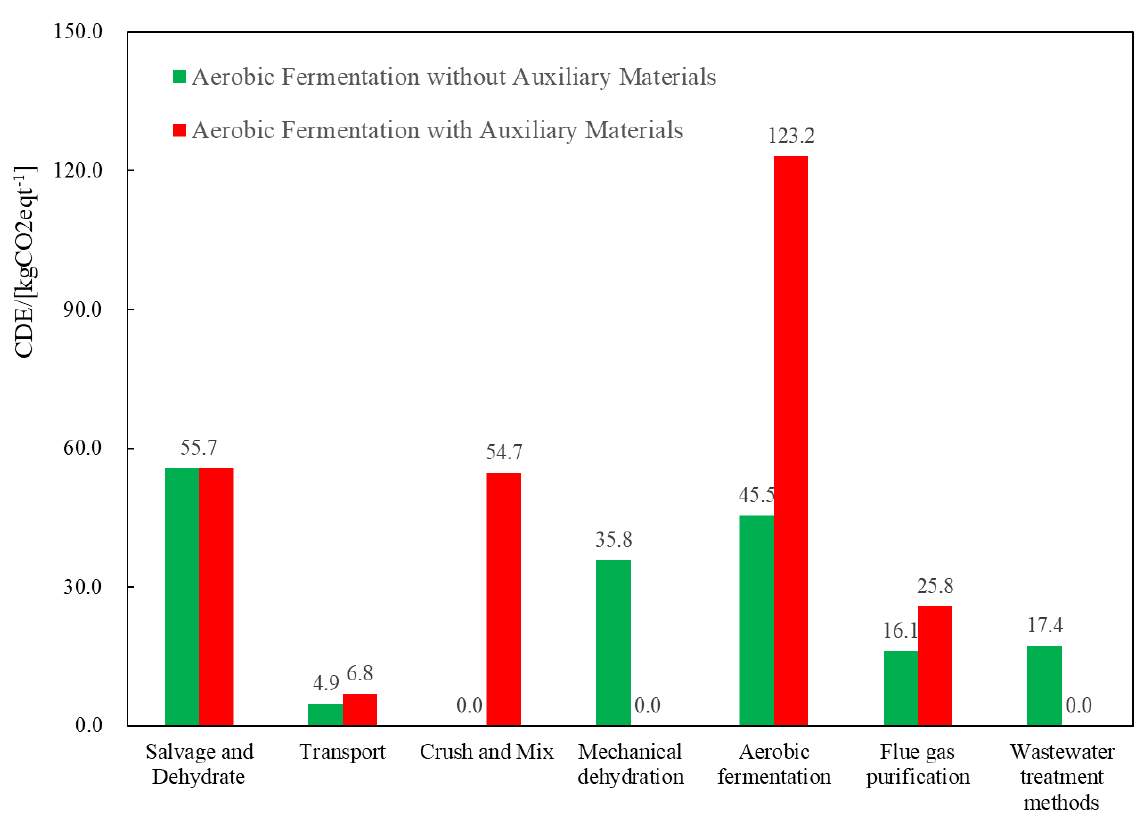
Figure 7. Carbon emission in each link of the aerobic fermentation process.